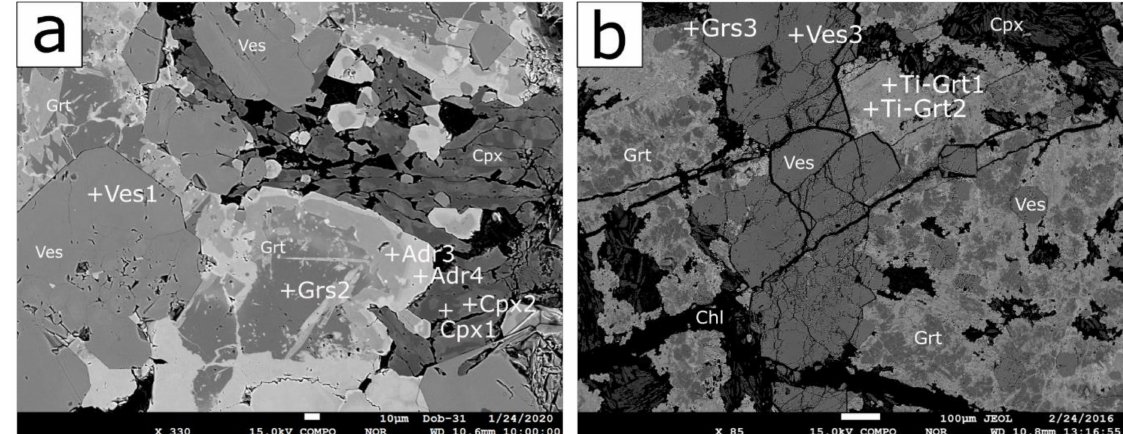
Figure 4. ( a ) BSE image of the complex garnet solid solution and its textural relation to clinopyroxene and euhedral vesuvianite; ( b ) BSE image of the locally Ti-enriched garnet solid solution cut by a later vesuvianite vein. Ves—vesuvianite; Grt—garnet; Adr—andradite; Grs—grossular; Cpx—clinopyroxene;